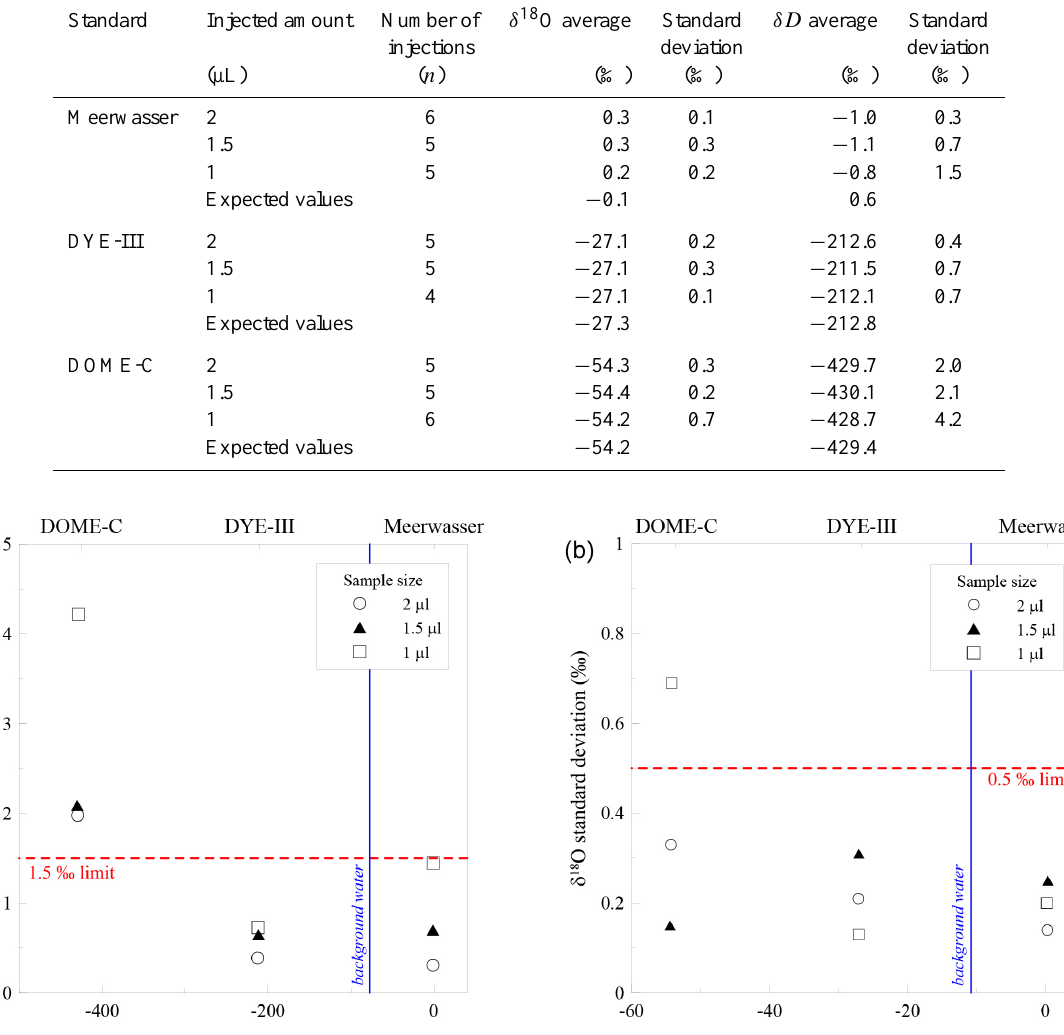
Table 3. Experimental results with injected aliquots of standard water (refer to Table 1 for uncertainties in the expected values). Note that the aliquots slightly deviate from values given in Table 1.